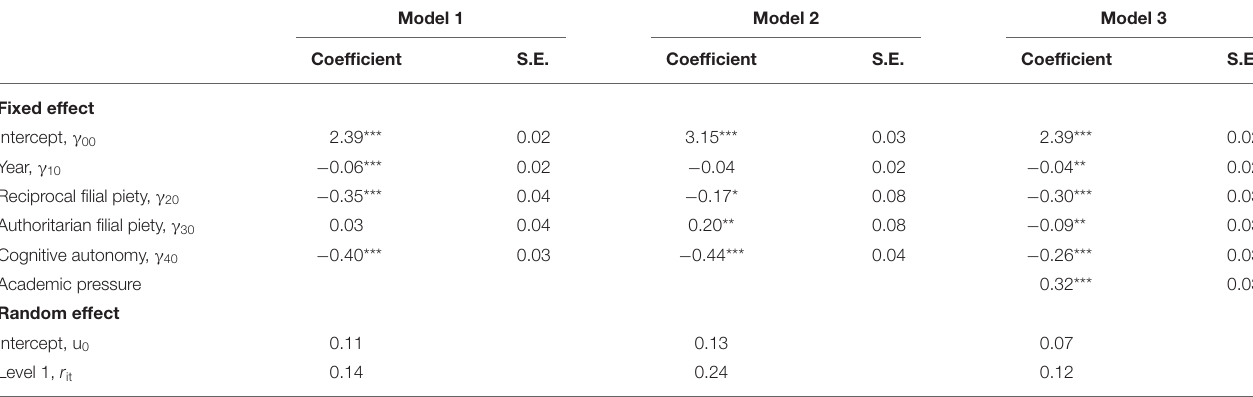
TABLE 2 | Results of HLM analyses for adolescents’ depressive